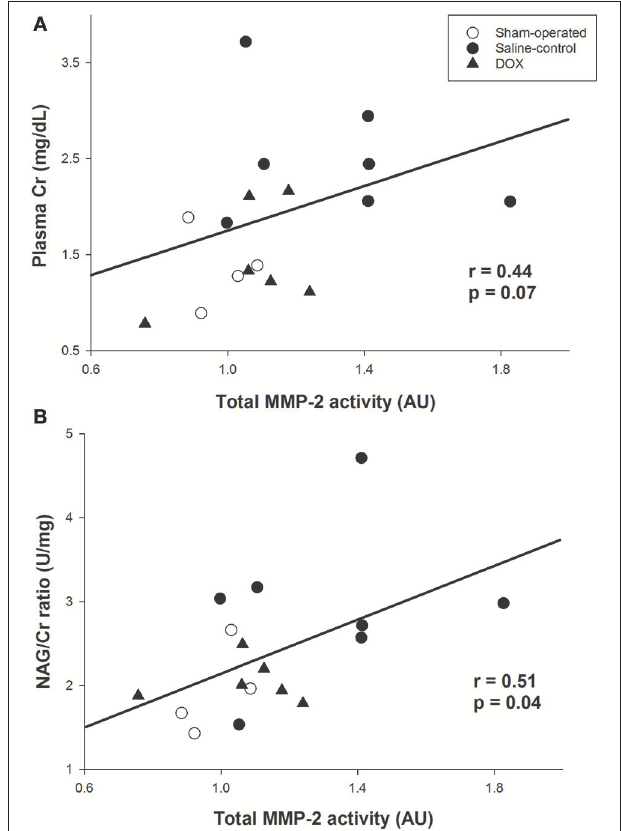
FIGURE 6 | Correlation between total MMP-2 activity and (A) plasma creatinine level, and (B) urine NAG /Cr ratio (Pearson Product Moment